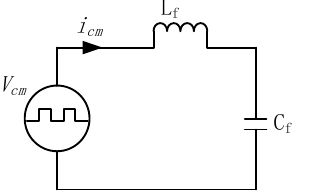
Figure 2. Common-mode (CM) voltage and current equivalent circuit for three-level inverter with ILC filter, without C pv considered.